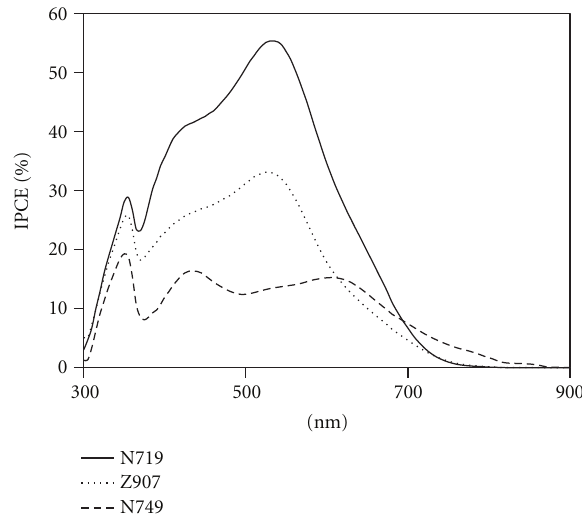
Figure 1: Comparison of typical IPCE spectra for the three di ff erent